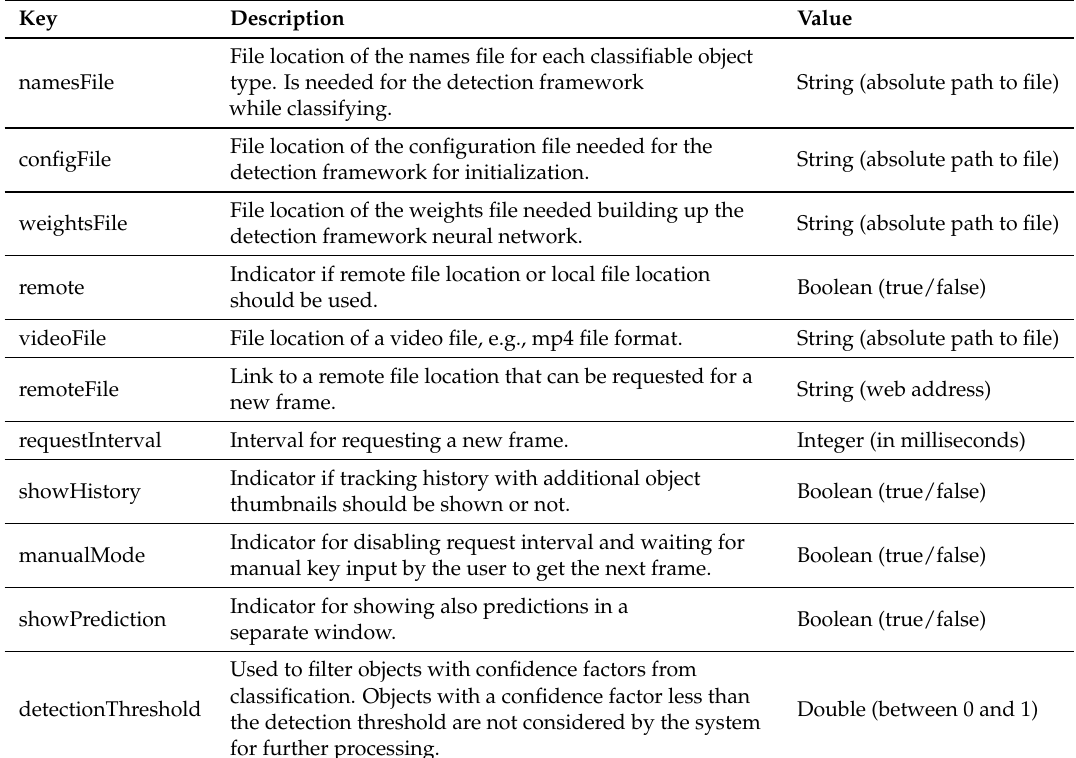
Table 1. Configuration file entries with additional